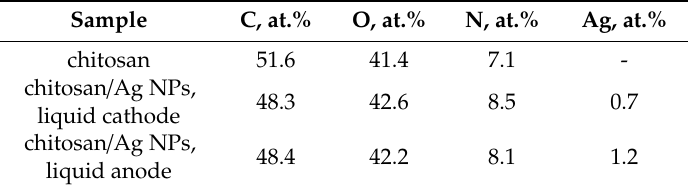
Table 1. Elemental composition of chitosan and chitosan / Ag NP foils determined by EDX. Sample C, at.% O, at.% Sample